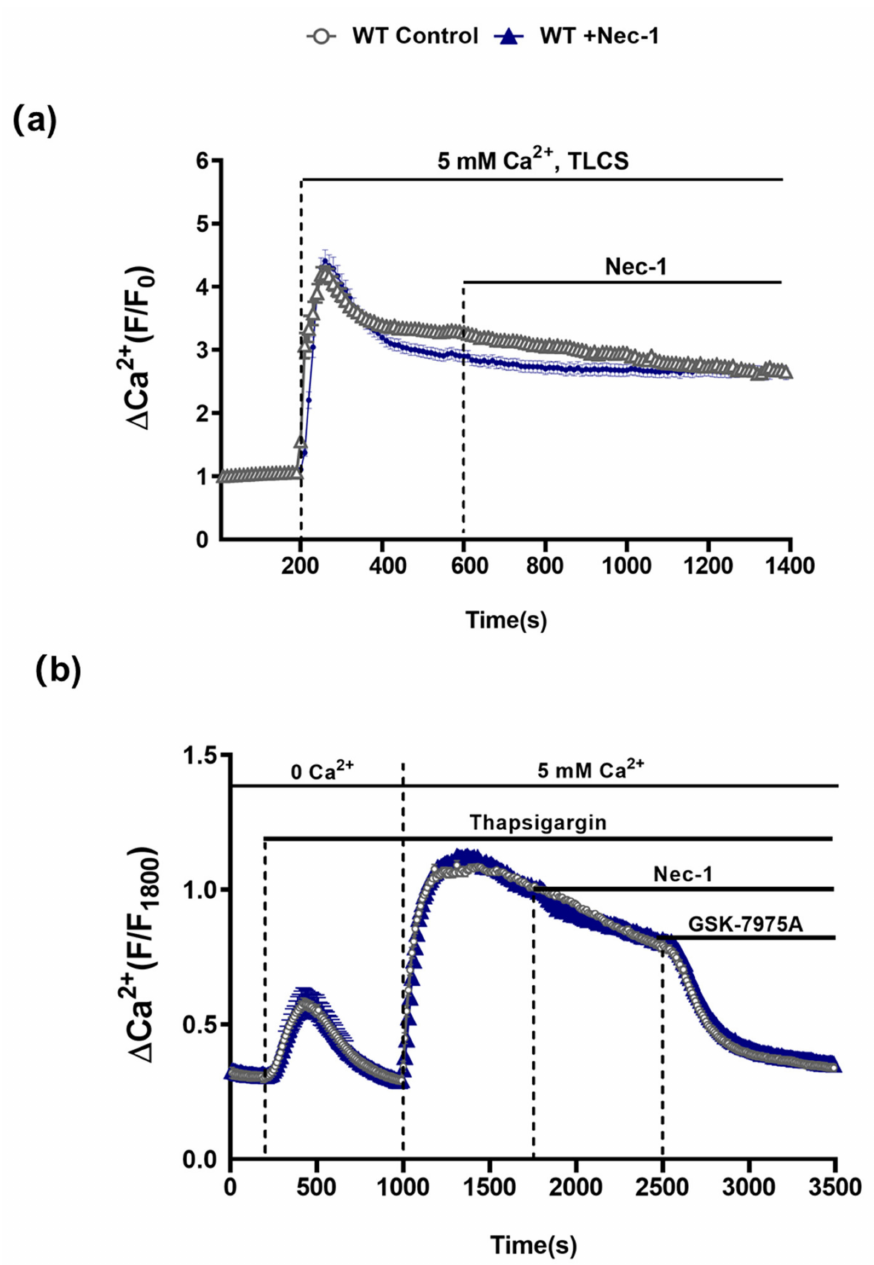
Figure 5. Nec-1 does not inhibit Ca 2+ entry mechanisms in PACs. ( a ) Graph showing the effects of Nec-1 (30 µ M) on TLCS (500 µ M)-induced sustained cytosolic Ca 2+ elevations (Fura2-AM) in PACs. TLCS (500 µ M) was applied at 200s (blue; n = 97 cells) and effects of Nec-1, added at 600 s, were compared to time-matched controls (black; n = 77 cells). ( b ) Graph showing the effects of Nec-1 (30 µ M) on store-operated Ca 2+ entry (SOCE) in PACs. Thapsigargin was applied under Ca 2+ -free conditions to elicit internal store depletion. Subsequently 5 mM Ca 2+ was added from 1000 s to 1800 s to induce SOCE; effects of Nec-1 applied at 1800 s (blue; n = 66 cells) were compared to time-matched controls (black; n = 54 cells). The Orai1 inhibitor GSK-7975A (10 µ M) was applied as a positive control at 2500 s to reverse the SOCE. Changes are normalized increases in fluorescence from the baseline (F/F 0 ) in ( b ) and (F/F 1800 ) in ( c ) and data expressed as the mean ± SEM ( n ≥ 3